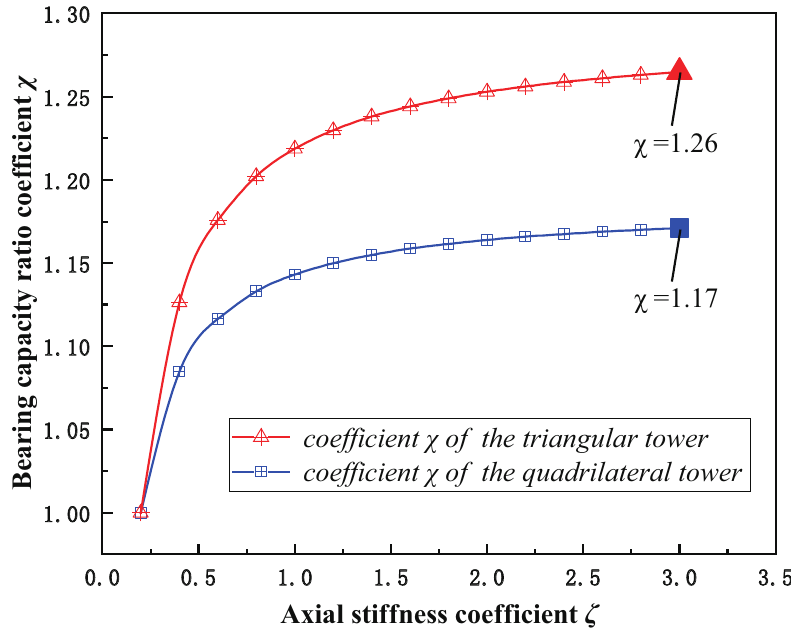
Axial stiffness coefficient ζ Figure 4. The bearing capacity variation coefficient curves of triangular and quadrilateral